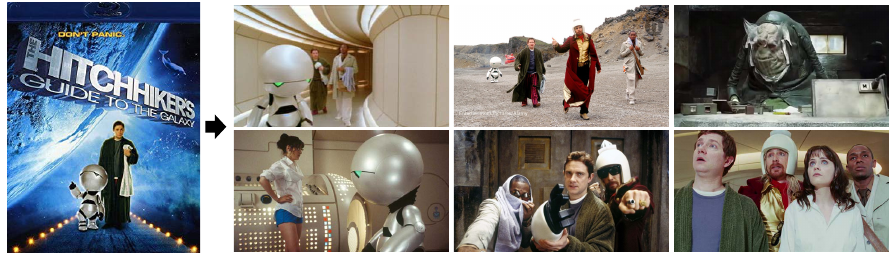
Figure 1. An example of providing additional images ( Netflix dataset).